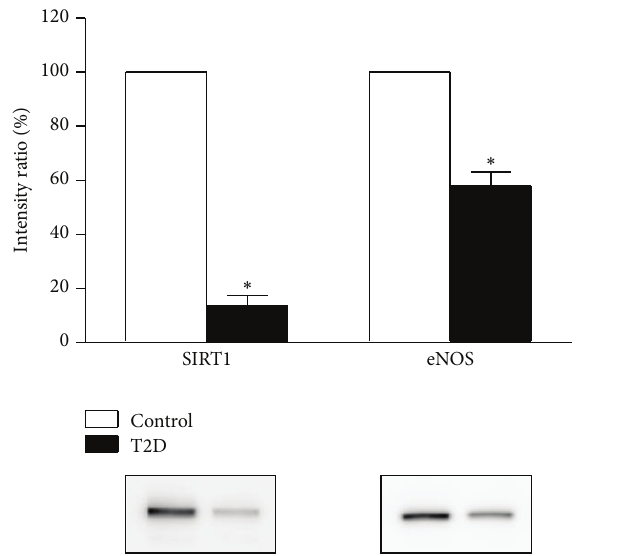
Figure 3: Arterial protein expression levels of SIRT1 and eNOS were decreased in T2D rats compared to control rats ( 𝑛 = 3 each; 𝑃 = 0.0082 and 𝑃 = 0.011 , resp.; 𝑡 -test). Representative immunoblots are shown below the summary data. Relative protein levels were calculated as the ratio of the intensity of the chemiluminescent bands to the intensity of the total protein loaded on the gel and are expressed as a percentage of the values measured in control rats.